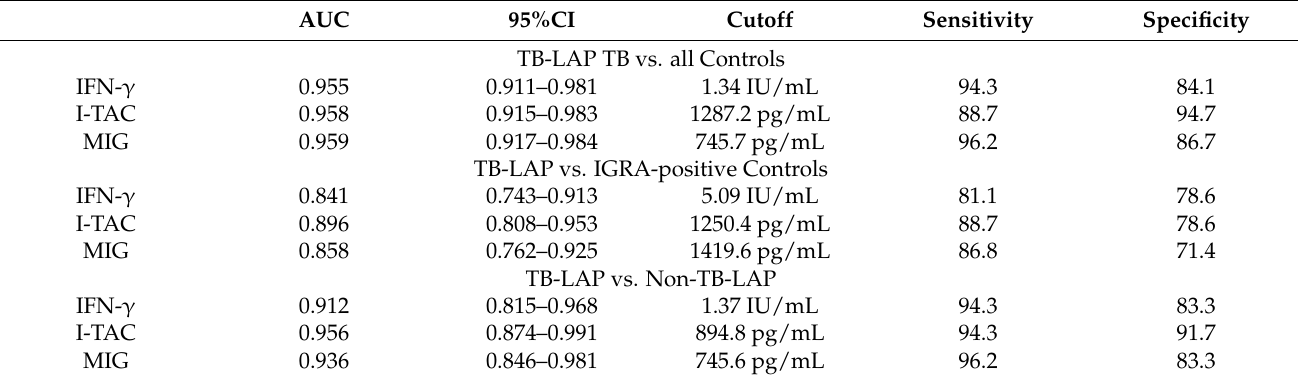
TB-LAP = tuberculous lymphadenitis; AUC = area under the curve; CI = confidence interval; IFN- γ =interferon- γ ; I-TAC = interferon- inducible T cell α chemoattractant; MIG = monokine induced by interferon- γ ; IGRA = interferon- γ release assay; non-TB-LAP = non- tuberculous